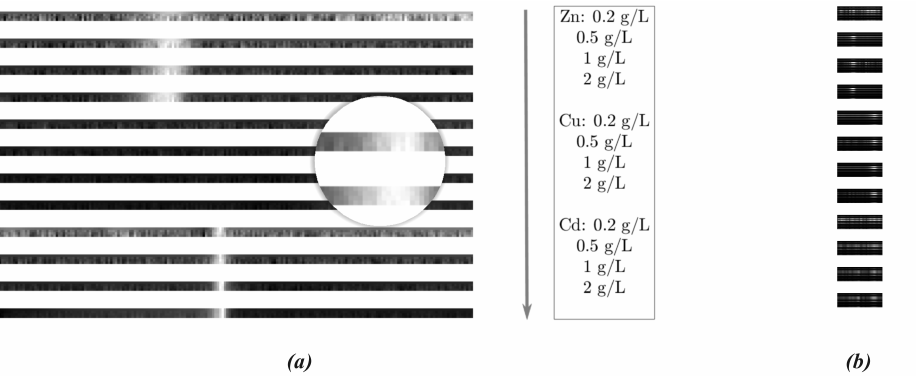
Figure 8. ( a ) Patterns of the HMI data matrices with size 4 × 200. ( b ) Features extracted from the